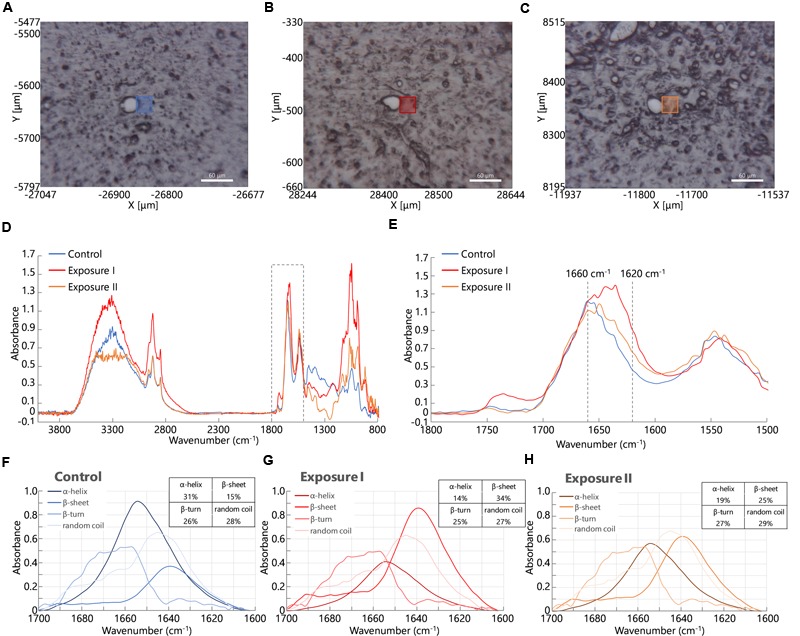
Infrared microspectroscopy in perivascular areas. Squares in (A–C) show brain areas where FT- IR spectra were measured in the control group (A). Carbon black nanoparticles exposure group (B,C). (D) Shows infrared spectra from each square (blue line: control group, orange and red lines: exposure group). (E) Shows enlarged spectra from the dashed line box in (D) to show the amide I peak-shift. (F–H) Spectra are obtained following deconvolution of the spectra in (E) using Spectra Manager software Ver. 2. The table at the upper right represents the proportions of the contents of each secondary structure calculated from peak intensities of the deconvoluted spectra around the amide I bands (Sarver and Krueger, 1991).